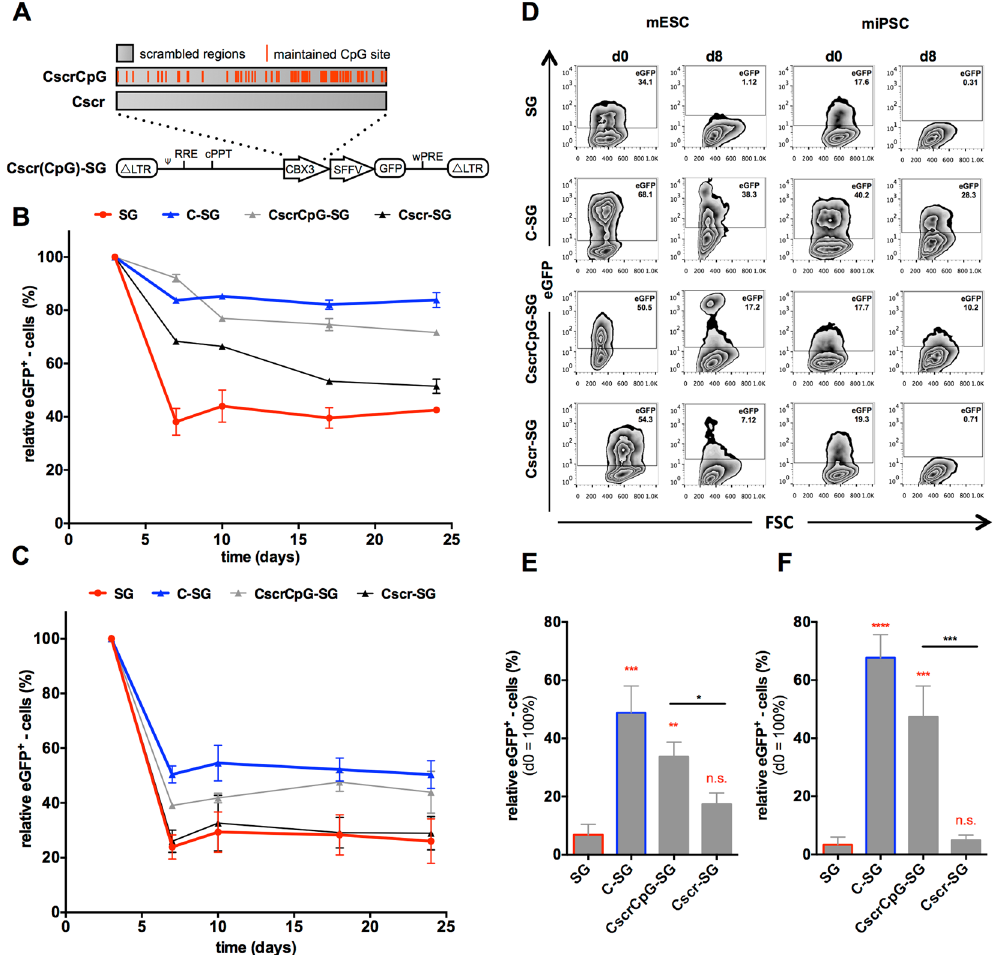
Figure 4. Anti-silencing activity of synthetic scrambled CBX3 elements. The DNA sequence of the CBX3 was shuffled randomly to create two synthetic elements that harbor the same nucleotide composition in a random order with one sequence maintaining the CpG-sites at their original position (CscrCpG) and the other completely destroying these sites (Cscr). ( A ) The elements were introduced into the SFFV.eGFP (SG) third generation SIN-lentiviral vector upstream of the promoter. ( B , C ) Following transduction, the eGFP expression was monitored by flow cytometry for 24 days in SSEA-1 positive ( B ) mESCs and ( C ) miPSCs. ( D–F ) The transduced cells were subjected to an EB-based undirected differentiation with transgene expression measured on day 0 and in SSEA-1 negative cells on day 8. ( D ) Representative flow cytometric analysis of mESCs and miPSCs prior to (d0) and after differentiation (d8). Relative eGFP expression was determined in differentiated (SSEA-1 negative) ( E ) mESCs and ( F ) miPSCs. Activity of the synthetic elements was compared to the SG negative control. Data represent independent experiments n = 3; mean ± SD; * p < 0.05, ** p < 0.01, *** p < 0.001, **** p < 0.0001 as determined by one-way